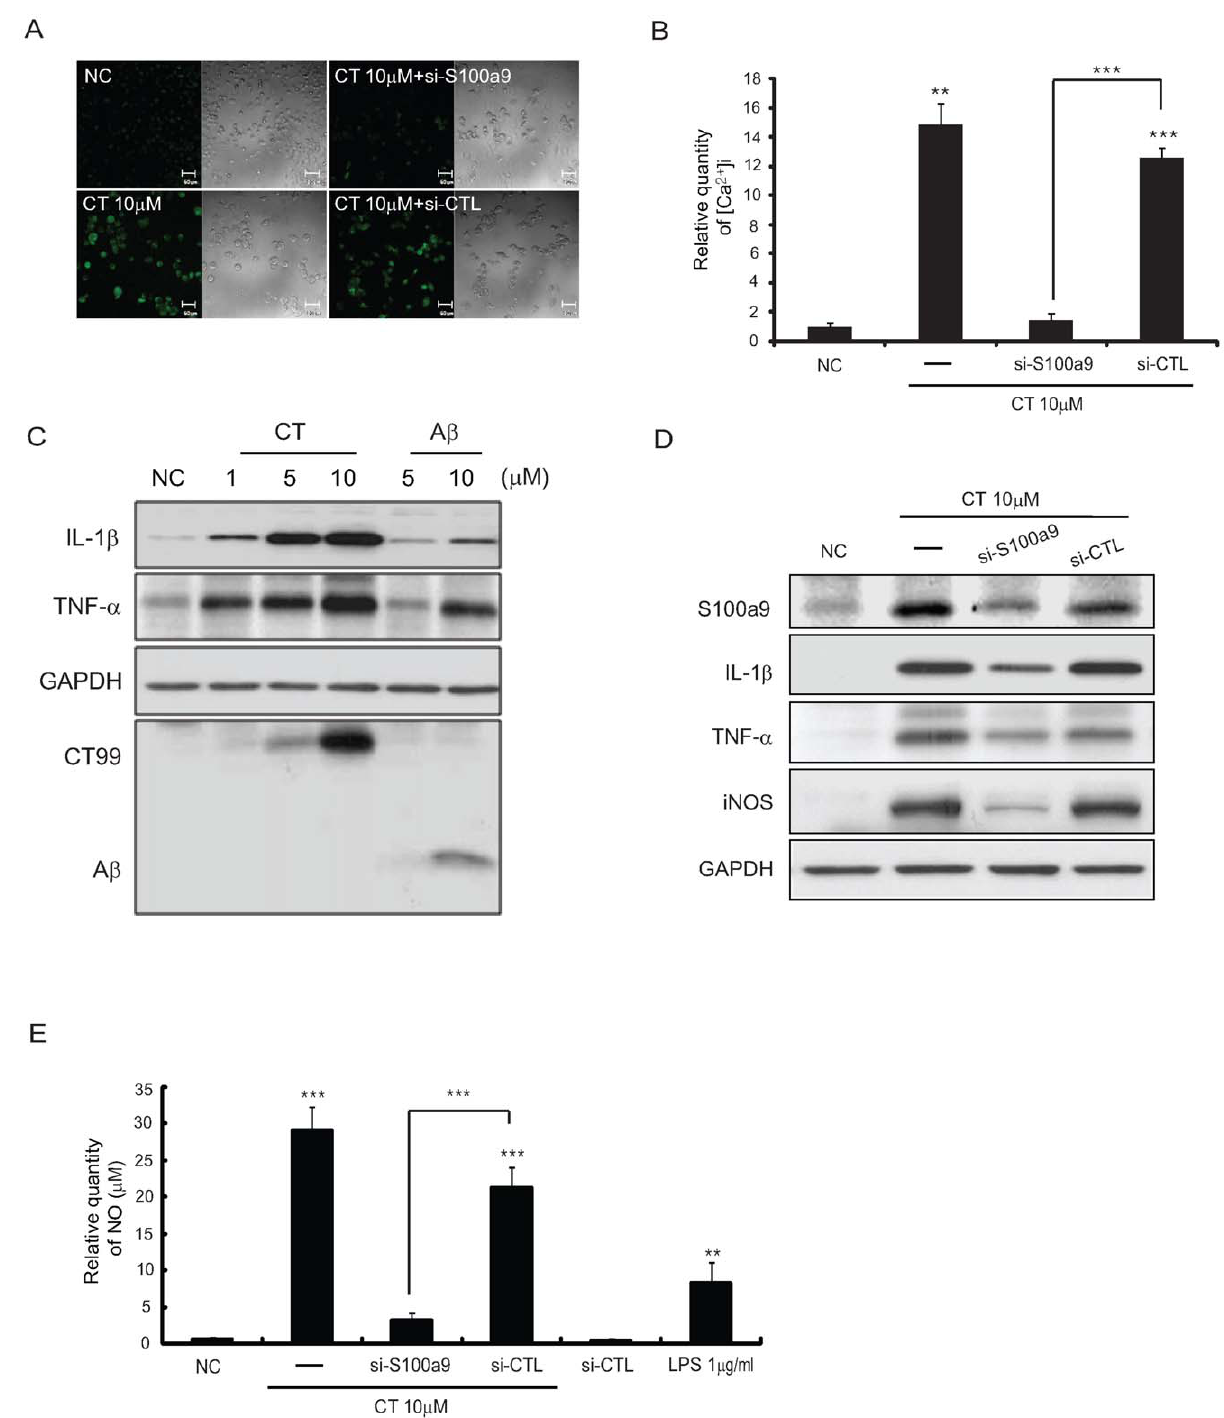
Figure 3. S100a9 induced by A b or CT increased [Ca 2 + ] i level and proinflammatory cytokines in BV2 cells. (A) [Ca 2 + ] i images obtained by Fluo3 AM at 48 h after treatment with 10 m M CT and 20 nM si-S100a9 in BV2 cells. Scale bars represent 50 m m. si-CTL is a control containing the scrambled sequence of S100a9 (B) The histogram shows the ratio of [Ca 2 + ] i levels to NC group. [Ca 2 + ] i levels in BV2 cells treated with CT and si-S100a9 was compared to that in BV2 cells with CT and si-CTL (control) (n=5). (C) After treatment with 1, 5, or 10 m M CT and 5 or 10 m M A b to BV2 cells, the levels of the pro-inflammatory cytokines, IL-1 b and TNF- a , were measured by western blotting. The membrane was stripped and reprobed with GAPDH to confirm equal loading and with 6E10 antibody to confirm intracellular CT and A b . (D) At 48 h post-treatment with si-S100a9, expressions of S100a9, IL-1 b , TNF- a and iNOS were attenuated. The membrane was stripped and reprobed with GAPDH to confirm equal loading. (E) At 48 h post- treatment with 10 m M CT and si-S100a9, NO release ( m M) was measured by Griess reagent. LPS (1 m g/ml) was used as a positive control. All data are presented as the means 6 SEM (n=10). NC: negative control (non-treated cell) **P , 0.01, ***P , 0.001 by Student’s t -test and one-way ANOVA.